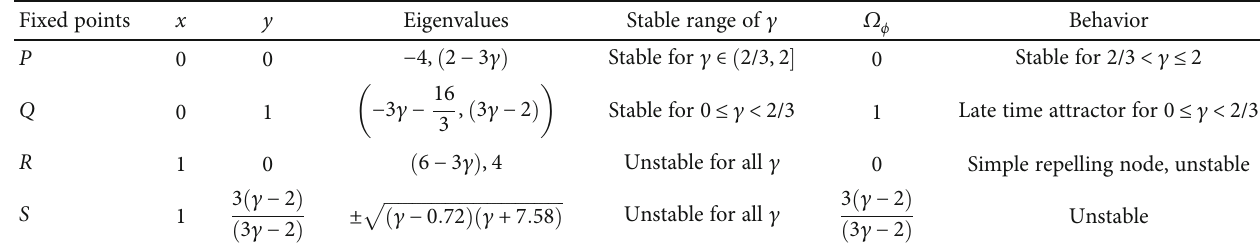
Table 1: Table for analysis without